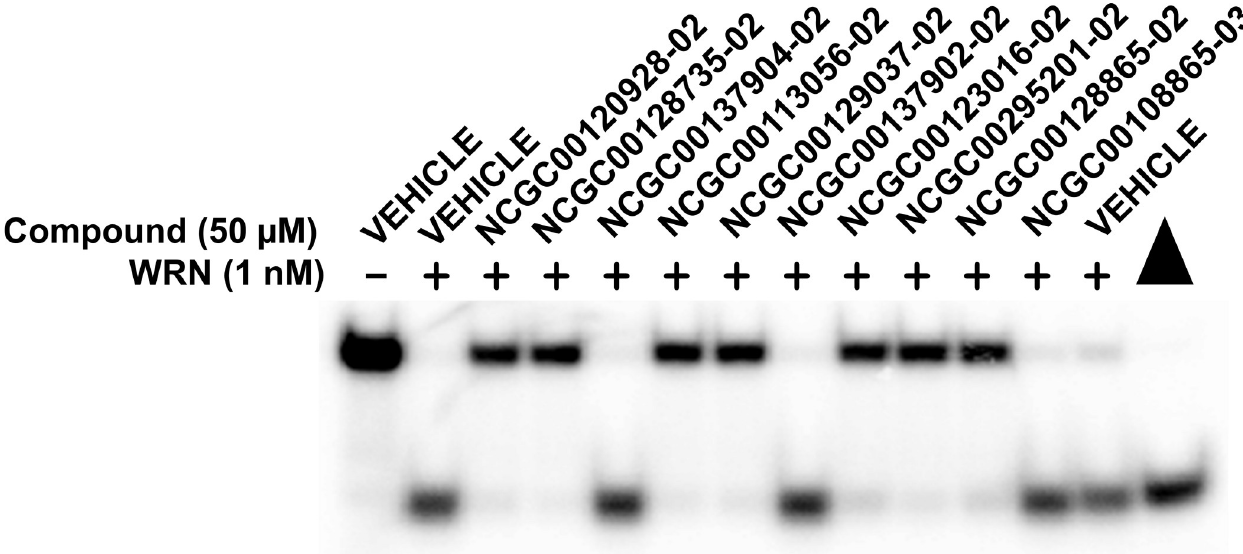
Fig 5. Confirmation of high-throughput screen compounds for inhibition of full-length WRN Helicase Activity. Gel image showing full-length WRN (1 nM) unwinding of the radiolabeled FORKR DNA substrate (0.5 nM) in the presence of 11 compounds at 50 μ M concentration from the high-throughput screen. Vehicle is DMSO. Filled triangle is the heat-denatured DNA control. https://doi.org/10.1371/journal.pone.0210525.g005 Table 1. Percent control WRN helicase activity with 50 μ M